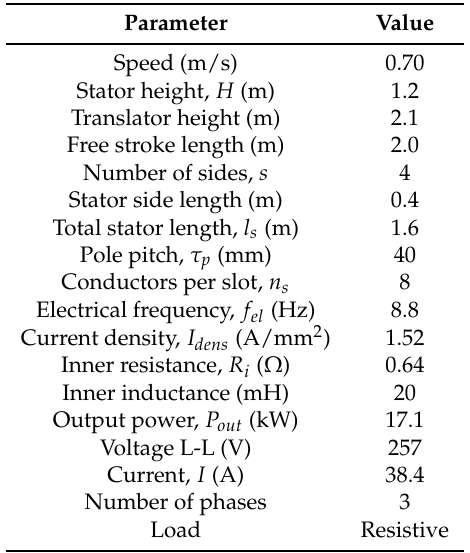
Table 1. Rated design parameters of the original generator, data adapted from